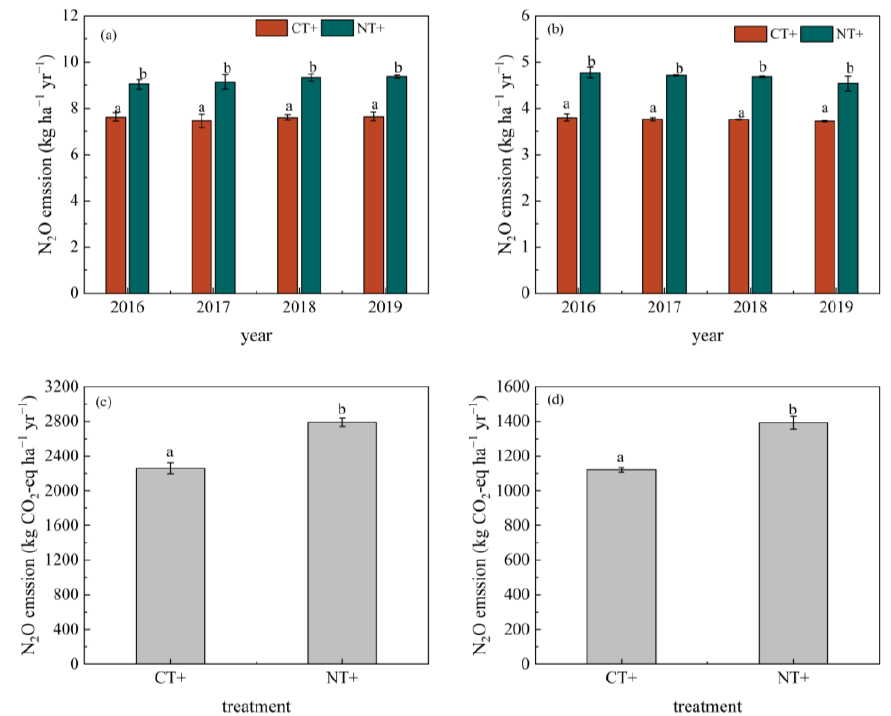
Figure 2. Soil N 2 O emissions from 2016 to 2019 at Wudi ( a ) and Yucheng ( b ); four-year average N 2 O emissions at Wudi ( c ) and Yucheng sites ( d ). CT+ is crop residue incorporated into soil with plough tillage, NT+ is crop residue mulching soil with no-till. The small letters indicate the significant differences across treatments at p < 0.05 level.